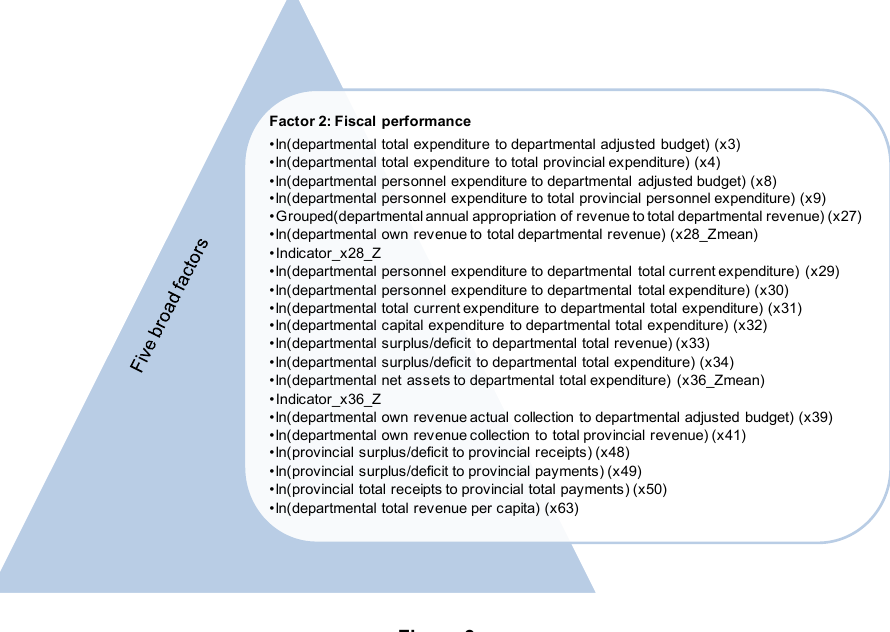
The two independent variables representing the financial and debt position broad